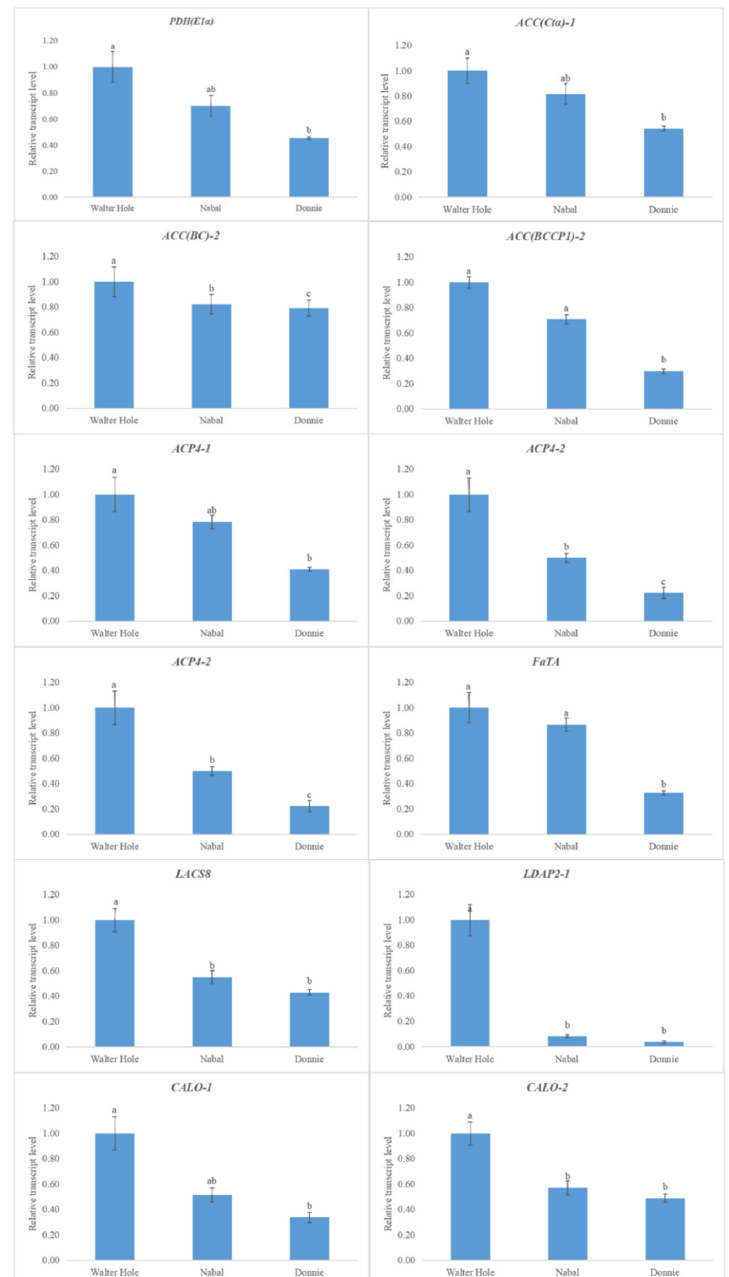
Figure 3. Relative expression patterns of twelve lipid ‐ related genes involved in FA synthesis and TAG storage in the mature avocado mesocarps of three ecotypes. Error bars indicate standard deviation from three biological replicates with two technical replicates of each. Means with different letters in the same color histogram indicate significant differences (Duncan, p ≤ 0.05).